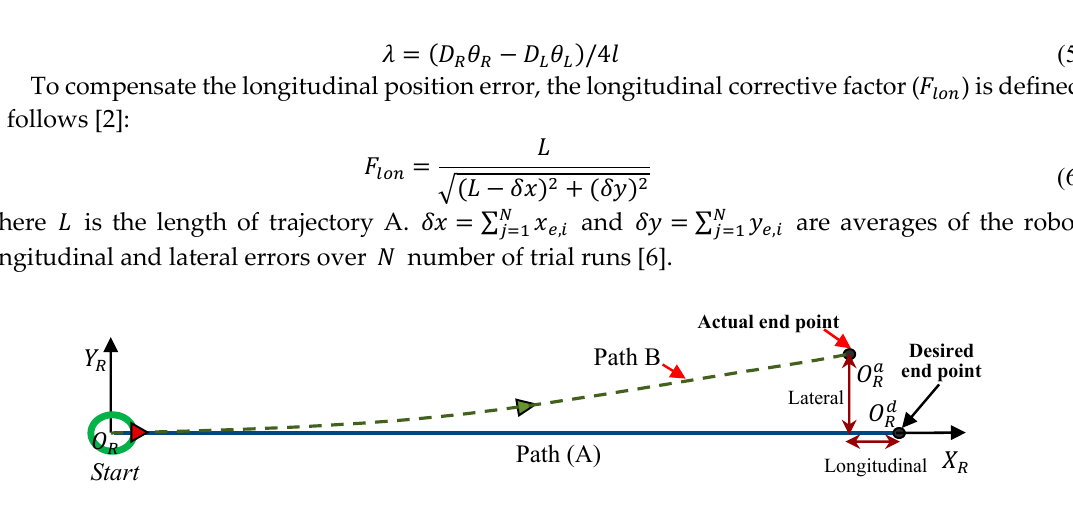
Figure 2. Trajectory taken by the differential drive WMR in the proposed technique.